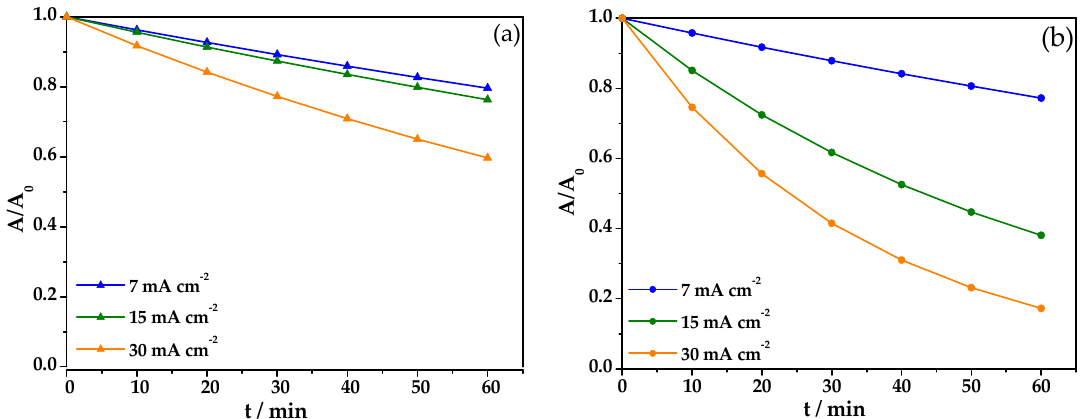
Figure 5. Removal of an aqueous solution of Blue BR (BBR) azo dye, C 0 = 50 mg/L, during the oxidation process in ( a ) 0.1 M of HClO 4 and ( b ) 0.05 M Na 2 SO 4 with a solution volume of 0.1 L.